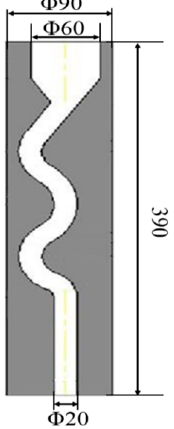
Figure 1. Schematic diagram of the serpentuator (unit: mm).